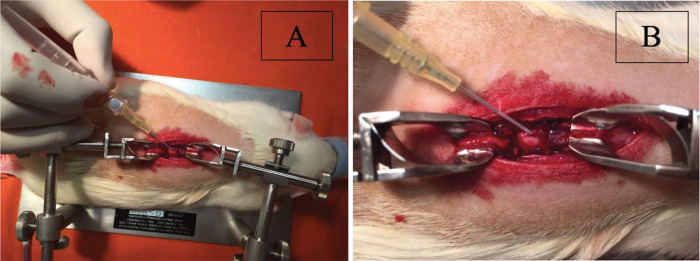
Center of laminectomy. A) Puncture of the dural sac at the center of laminectomy at the site of experimental spinal cord contusion. B) Needle removal and intrathecal introduction of the catheter approximately 5 mm in length.